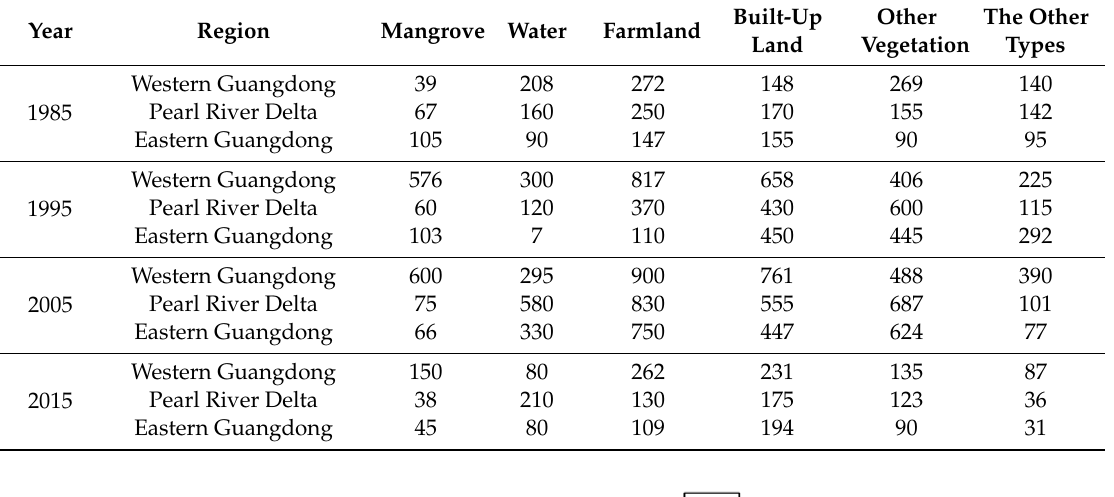
Table 2. Number of polygon samples selected for training classification rules.